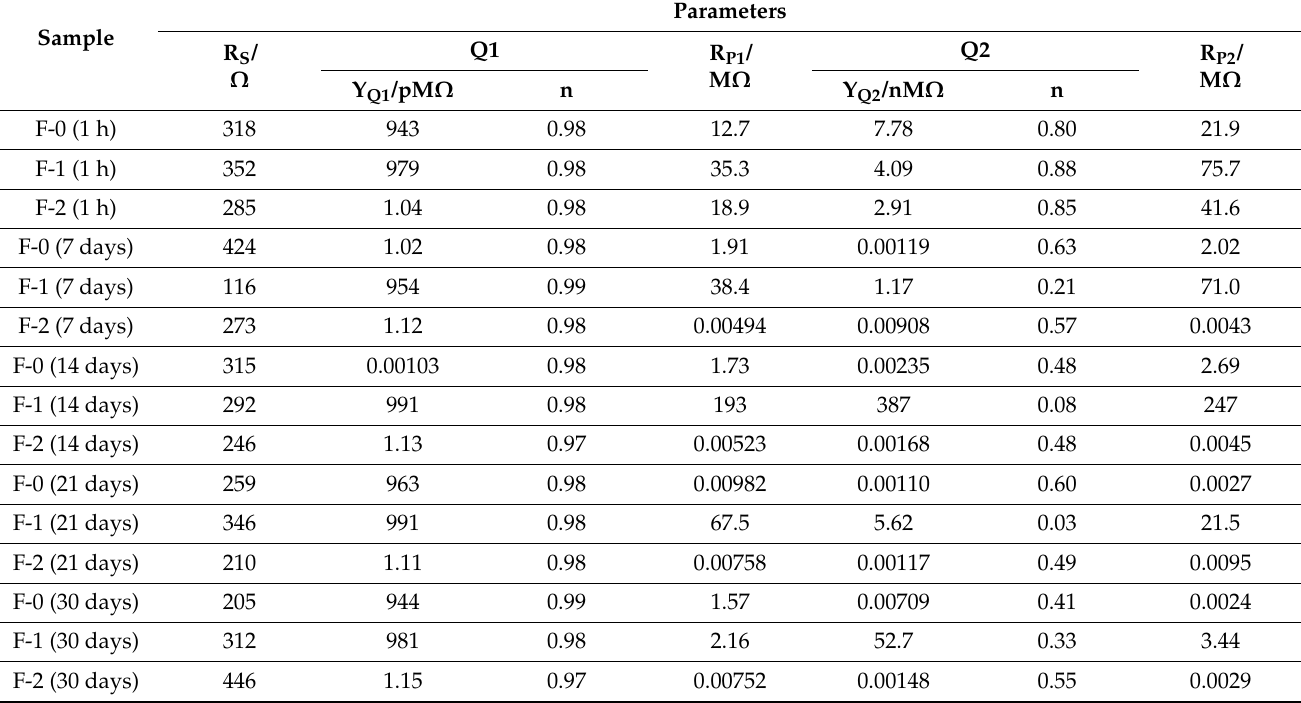
Table 6. EIS parameters obtained by fitting the Nyquist plots for coating containing